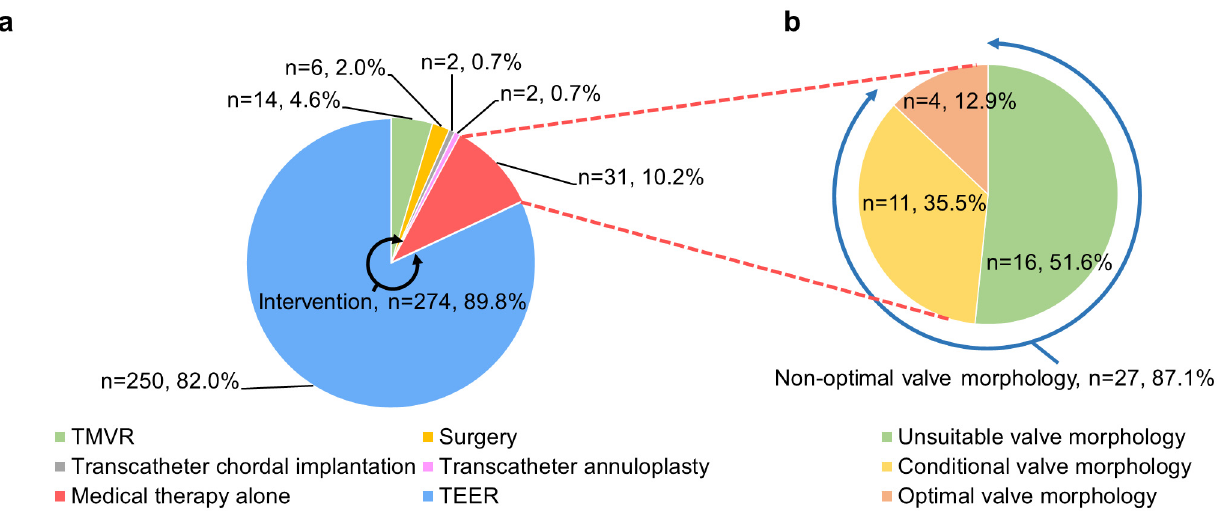
Figure 2. Contemporary therapeutic management of high surgical risk MR. Mitral valve intervention was performed in 89.8% of patients with high surgical risk, of which TEER was the most common approach. In contrast, 10.2% were treated with medical therapy alone ( a ). Among patients treated with medical therapy alone, 87.1% showed non-optimal valve morphology for TEER ( b ). Abbreviations: MR, mitral regurgitation; TEER, transcatheter edge-to-edge repair; and TMVR, transcatheter